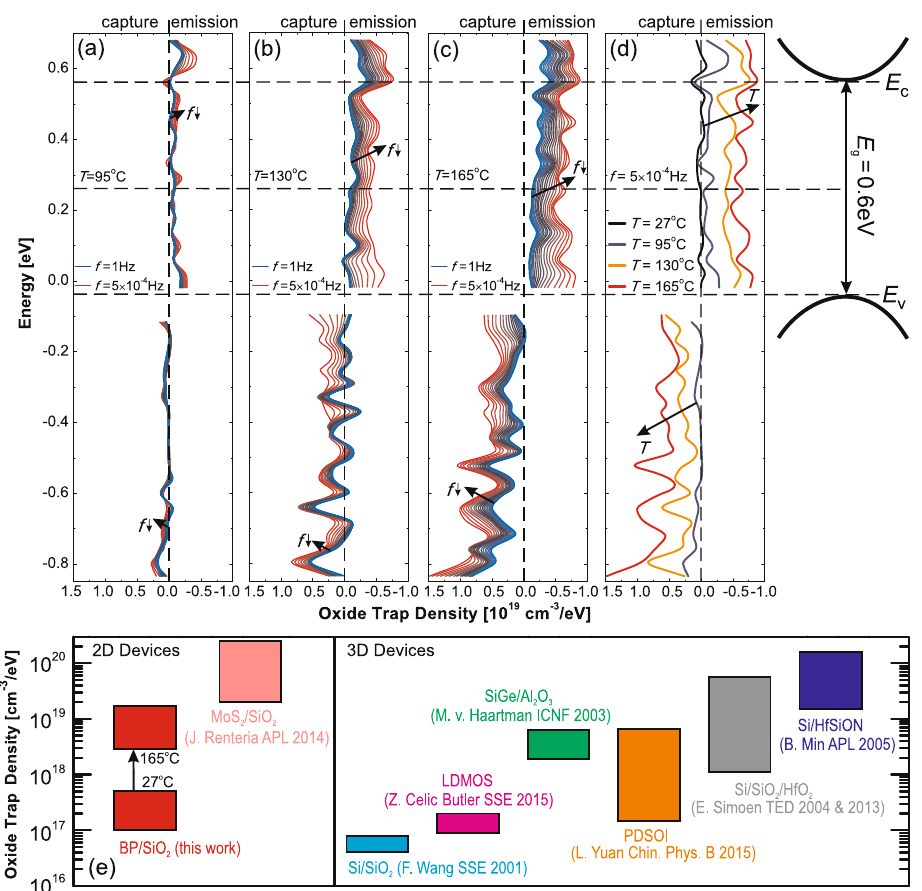
Fig. 4 The differential energy distributions of the oxide trap density D ot ( E ) for a T = 95 °C, b T = 130 °C and c T = 165 °C; the measurement frequency f is spaced logarithmically between 5 × 10 − 4 and 1 Hz. At higher temperatures the D ot ( E ) dependences are more sensitive to the measurement frequency, while the trap density is larger. d The energy distributions of slow oxide traps ( f = 5 × 10 − 4 Hz) obtained for three different temperatures. Due to thermal activation, the effective trap density becomes larger at higher temperatures. e Comparison of typical D ot values for our BPFETs with literature reports for different technologies. 33 –